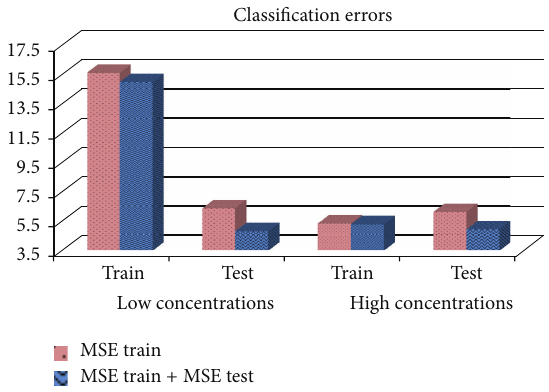
Figure 7: Classification errors according to the used fitness func-